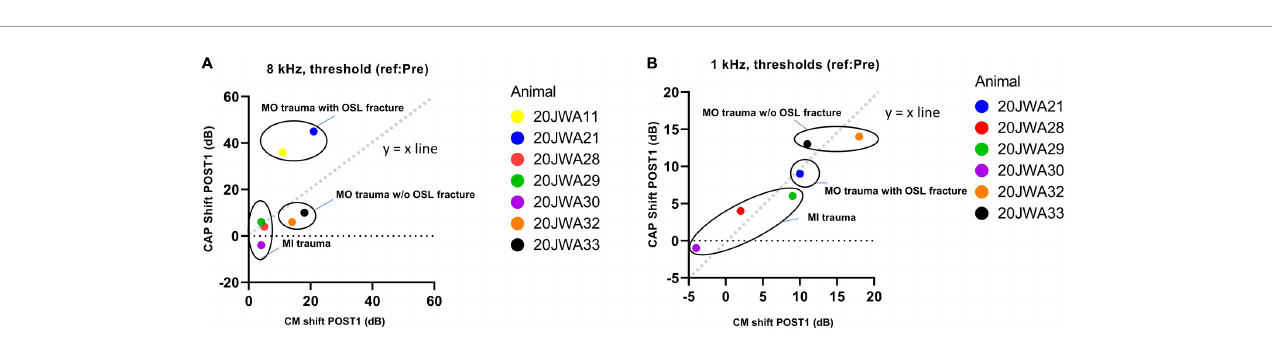
FIGURE12 The correlation between the CAP shift and cochlear microphonics (CM) shift at POST1 stage was assessed. 20JWA11 CM threshold at 1 kHz was near the artifact threshold and is therefore omitted. The threshold shifts are shown for responses to 8 kHz (A) and 1 kHz (B) tone. Individual datapoints are shown. Animals with osseous spiral lamina (OSL) fracture had higher CAP threshold shifts than CM threshold shift at 8 kHz (A) . However, at 1 kHz, the CAP and CM threshold shift were strongly correlated, with Spearman’s r = 0.95, with p =